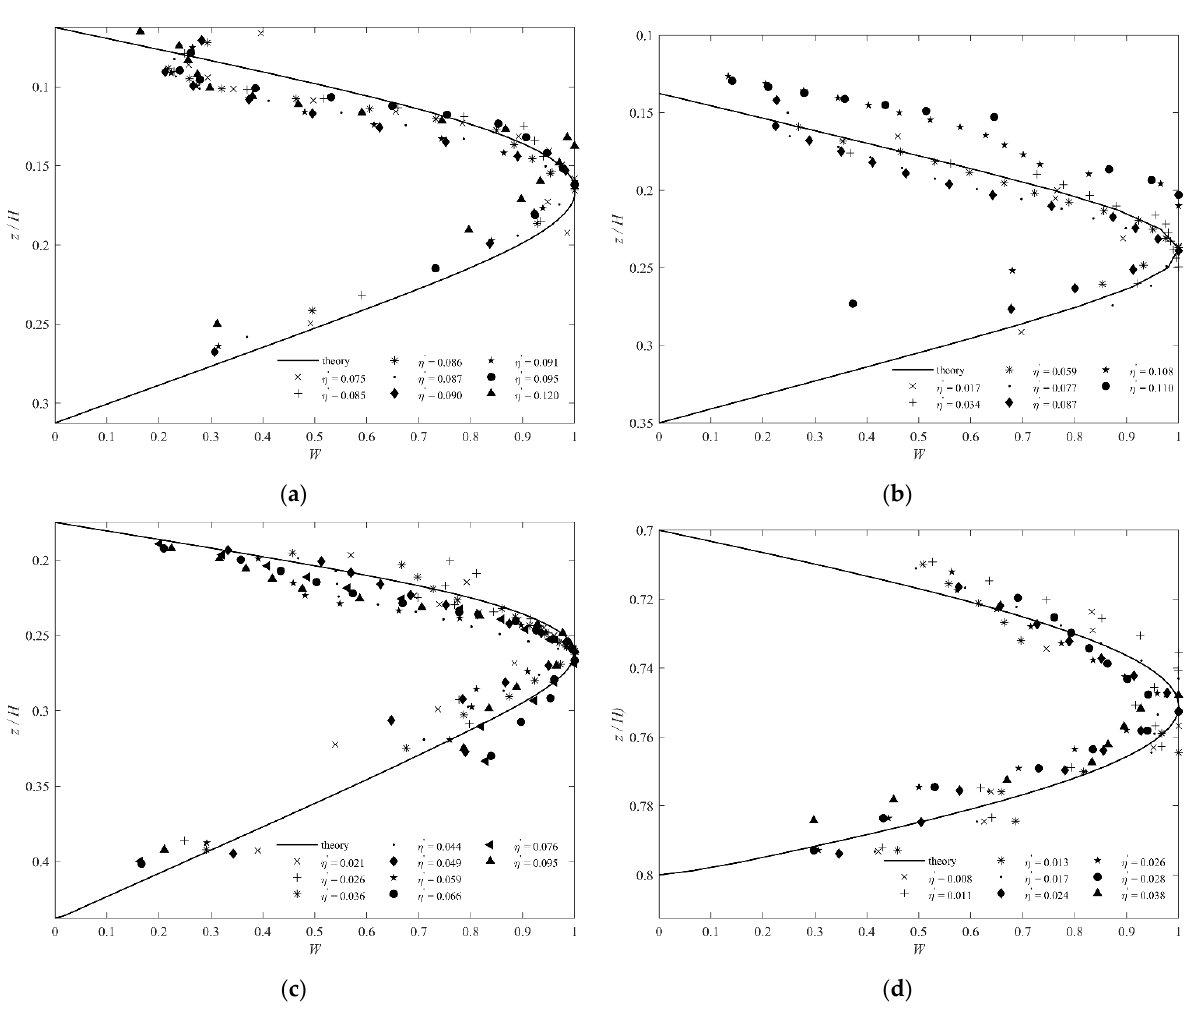
Figure 4. Experimental vertical structure of the amplitude and theoretical vertical mode function: